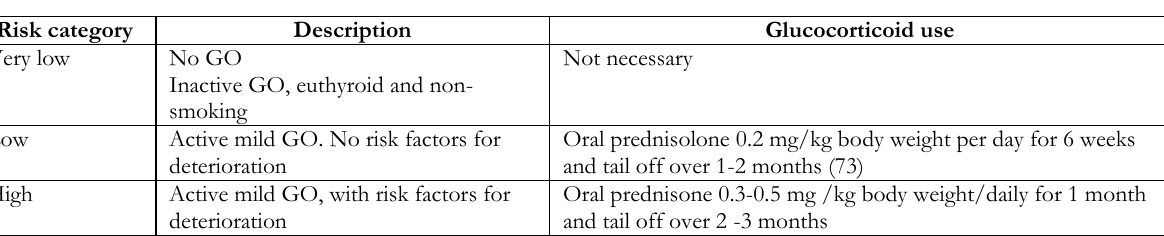
Risk factors for GO deterioration are smoking and high TRAb